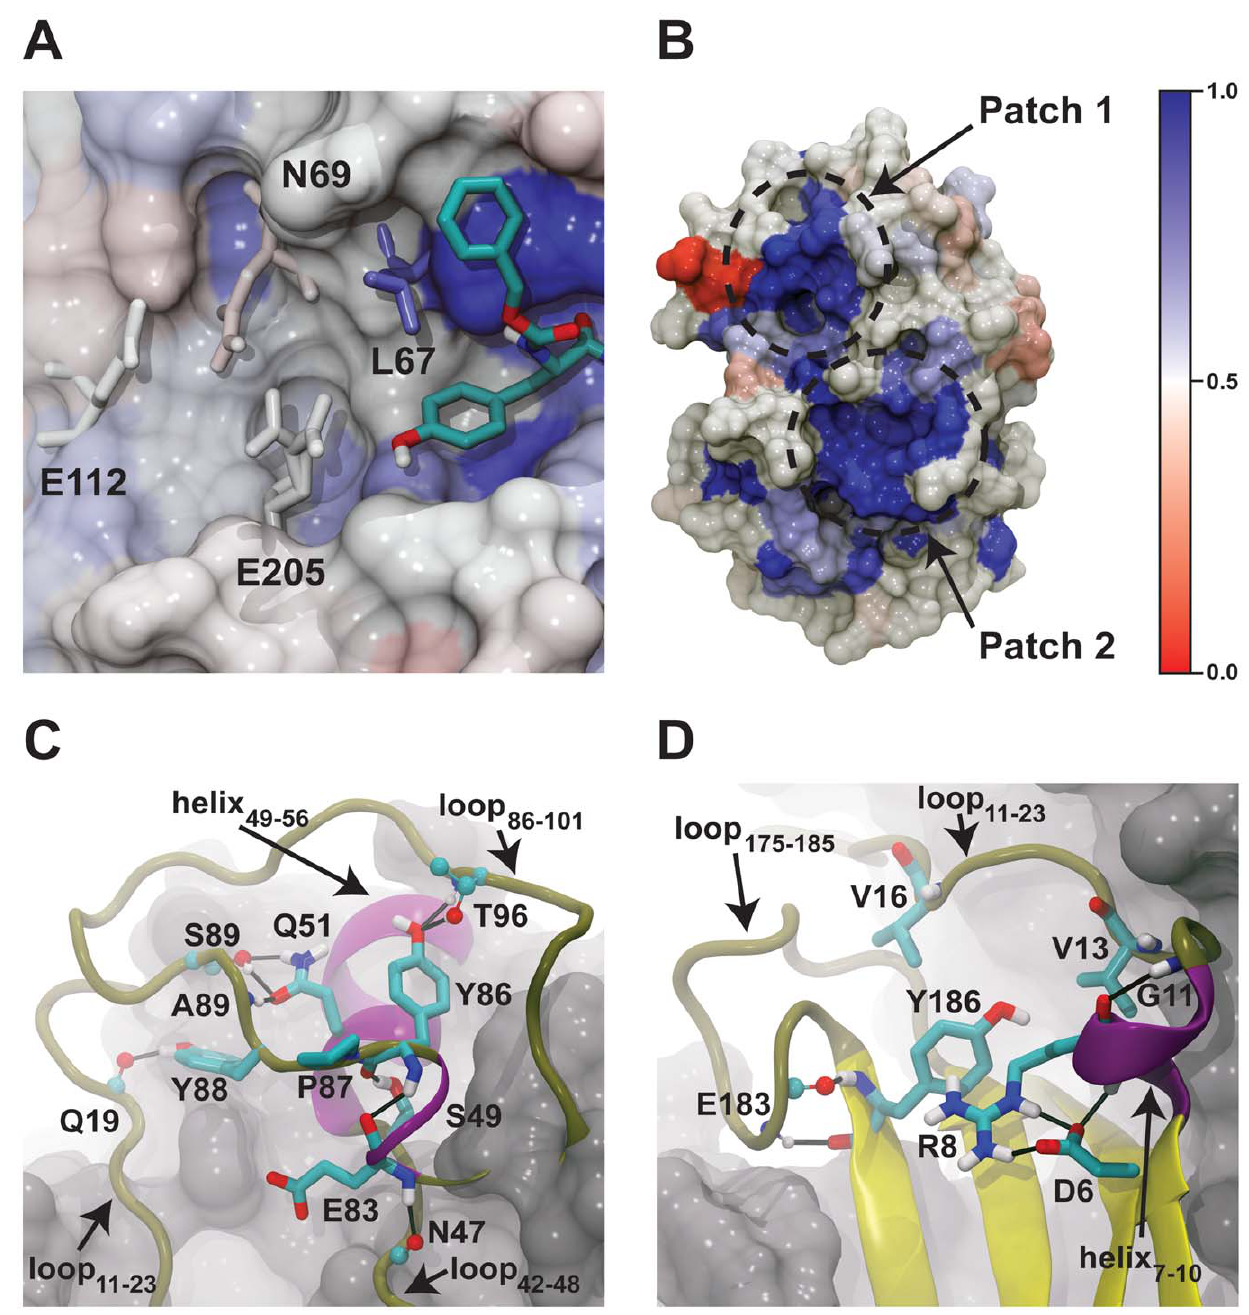
Figure 6. Cruzain (PDB: 1AIM) colored by residue conservation across multiple members of the peptidase C1 family. Conserved residues are shown in blue, and nonconserved residues are shown in red. A) The residues of the seven peptide-binding subsites are generally conserved. The S2 subsite, critical for specificity, is an important exception. Additionally, one of the residues of the previously uncharacterized binding pocket immediately beyond the S2 subsite, L67, is well conserved, while the remaining three residues of the pocket, N69, E112, and E205, are not. B) Two patches of highly conserved residues on the side of the protein opposite the proteolytic active site can be seen. The first, patch one, is comprised of Y88, P87, E83, Y86, Q51, and S49. The second, patch two, is comprised of Y186, R8, V16, G11, D6, and V13. C) A close-up view of the first patch. Conserved residues are shown in licorice, and non-conserved residues are shown in balls and sticks. Side chains or backbone atoms that do not participate in hydrogen bonds have been removed for the sake of clarity. D) A similar close-up view of the second conserved